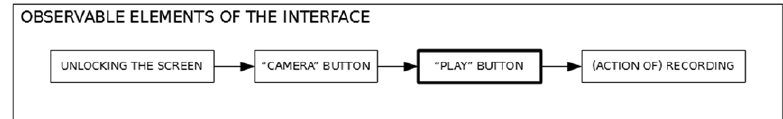
Figure 5: Contiguity relations in action button for action (author’s own